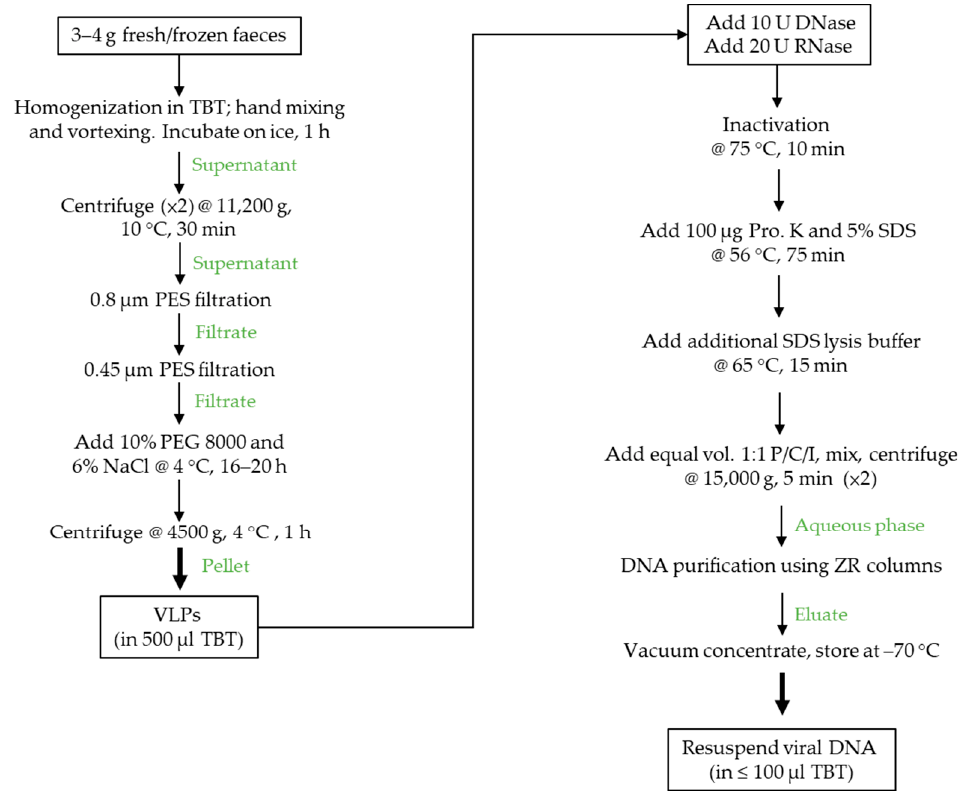
Figure 1. Workflow of the VLP isolation and VLP DNA extraction protocol. Three- to four-gram aliquots of faecal material were homogenised, centrifuged to remove debris and large particulate matter and then sequentially filtered through 0.8 µm and 0.45 µm cartridge PES filters to remove remaining contaminants and bacteria followed by enrichment of VLPs by PEG precipitation. Recov- ered VLPs were treated with DNase/RNase to remove non-capsid-associated nucleic acids prior to disrupting viral capsids with proteinase K/SDS. Released capsid nucleic acids were treated with P/C/I prior to column purification. DNA was eluted, vacuum concentrated to 60–100 µL and then stored at − 70 °C prior to use.